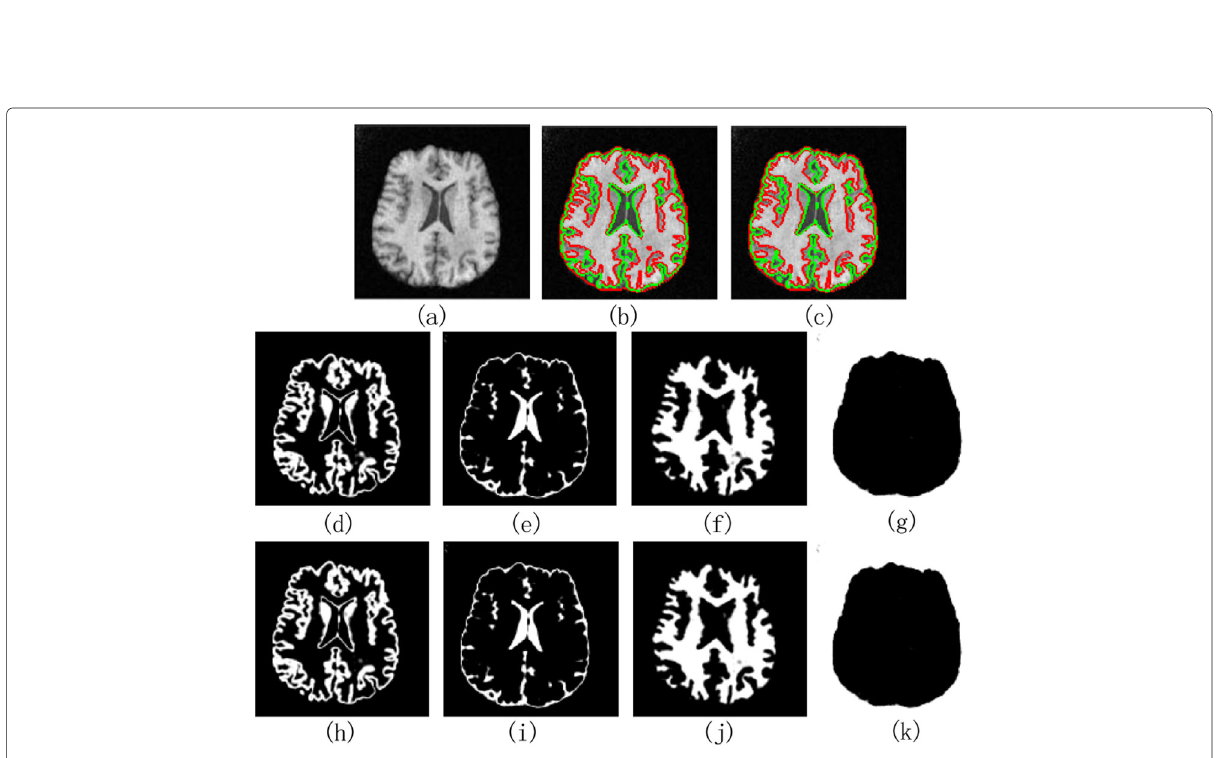
Fig. 3 Four-phase segmentation of the classic optimization method and ADMM. a The input brain MR image. b The segmentation result of classic optimization method. c The segmentation result of ADMM. d – g Different regions obtained via the classic optimization method. h – k Different regions obtained via